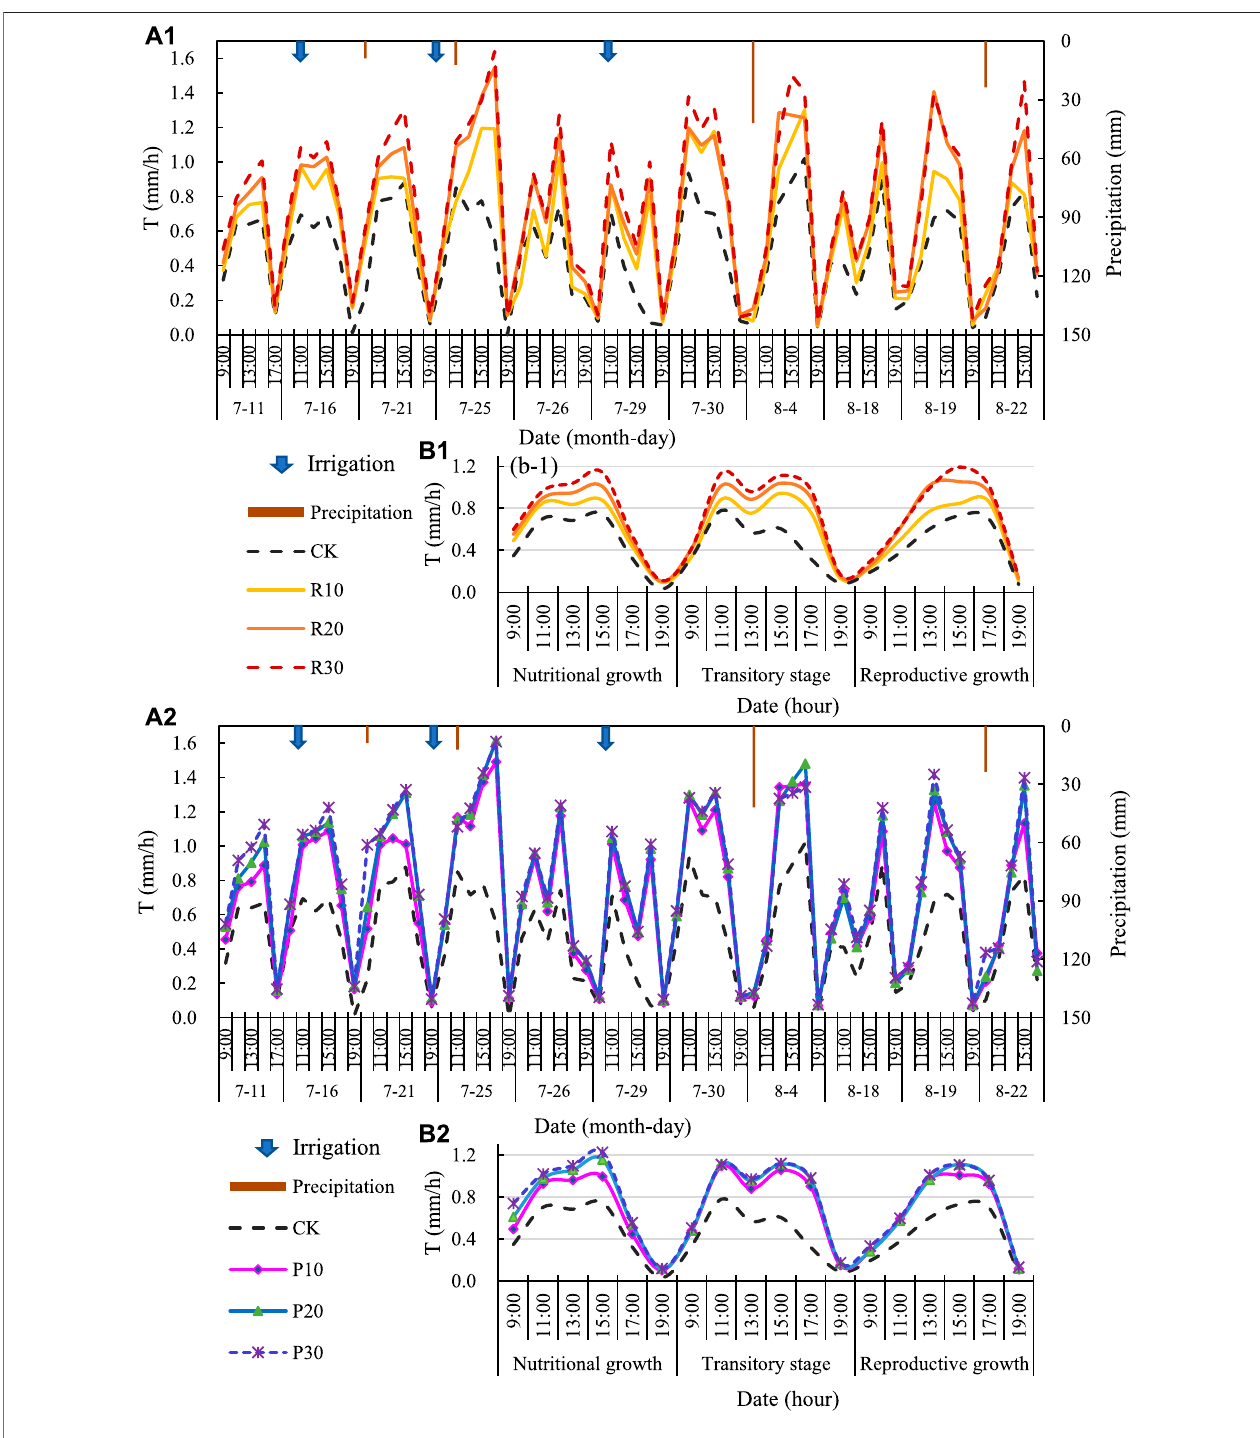
FIGURE 6 | Diurnal variations of the alfalfa transpiration rates under (1) traditional drip irrigation and (2) alternate drip irrigation with different irrigation quotas in (A) irrigation season and (B) growth stages based on UAV monitoring. The values of the three growth stages are multi-day averages, and precipitation data are for the fi rst 2 days of the observation